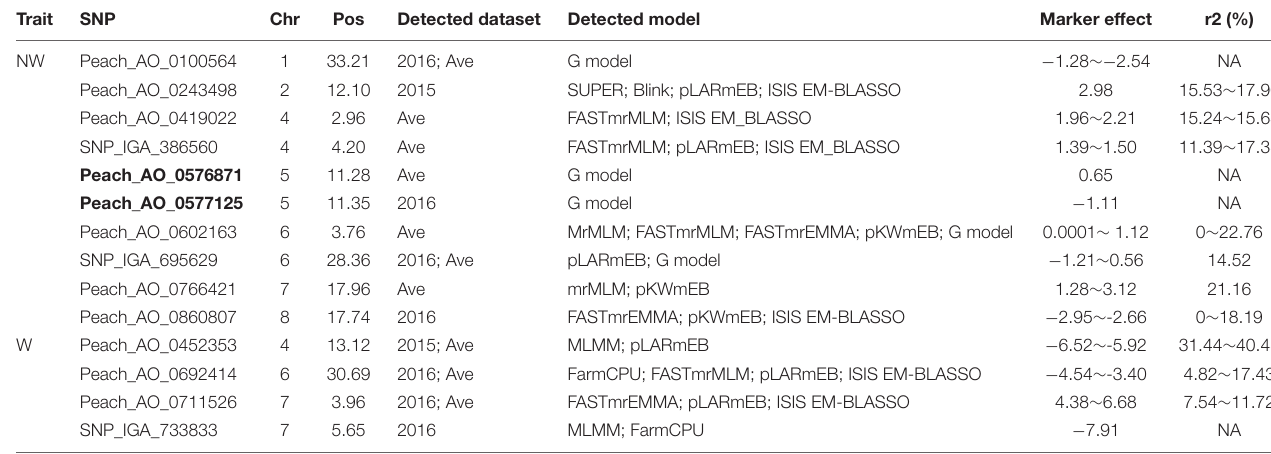
TABLE 3 | Significant markers associated with disease severity index (DSI) in wounded (W) and non-wounded (NW) treatments either repeatedly detected in at least two methods and/or two datasets using GAPIT version 3, mrMLM 4.0 and FarmCPU; or sharing the same haploblock to the markers detected in